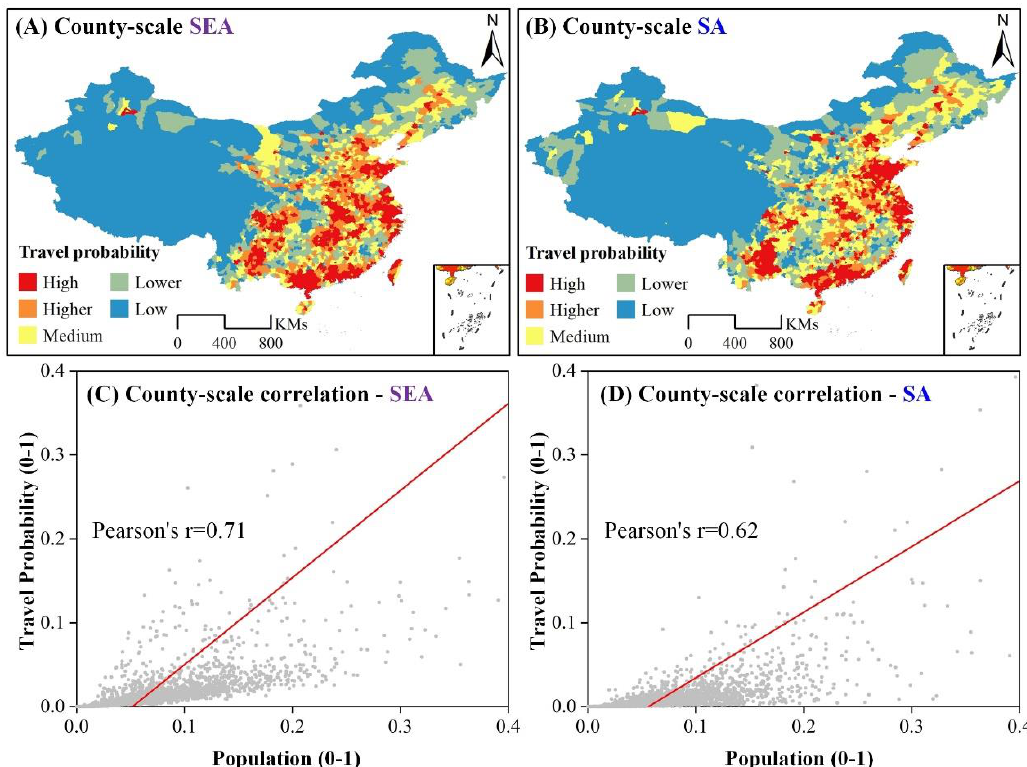
Figure 5. County scale travel probability from China to SEA ( A ) and SA ( B ); County scale correlation between population and travel probability for SEA ( C ) and SA ( D ); travel probability and population are normalized to 0–1 and data in 0.6–1 are hidden due to poor data quantity. The figure is under the WGS-84 geographical coordinate system.